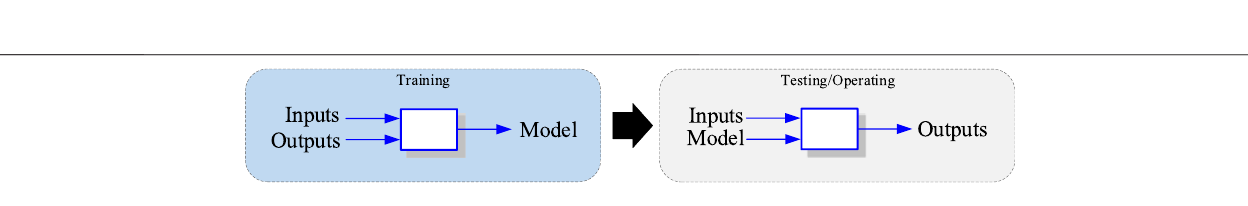
FIGURE5| Comparison betweentheproposedAI-basedmodeestimationapproachandthetraditionalsignalprocessingtechniques. AproperlytrainedAImodel can provide fast and accurate estimations of the mode frequency faster than signal processing.